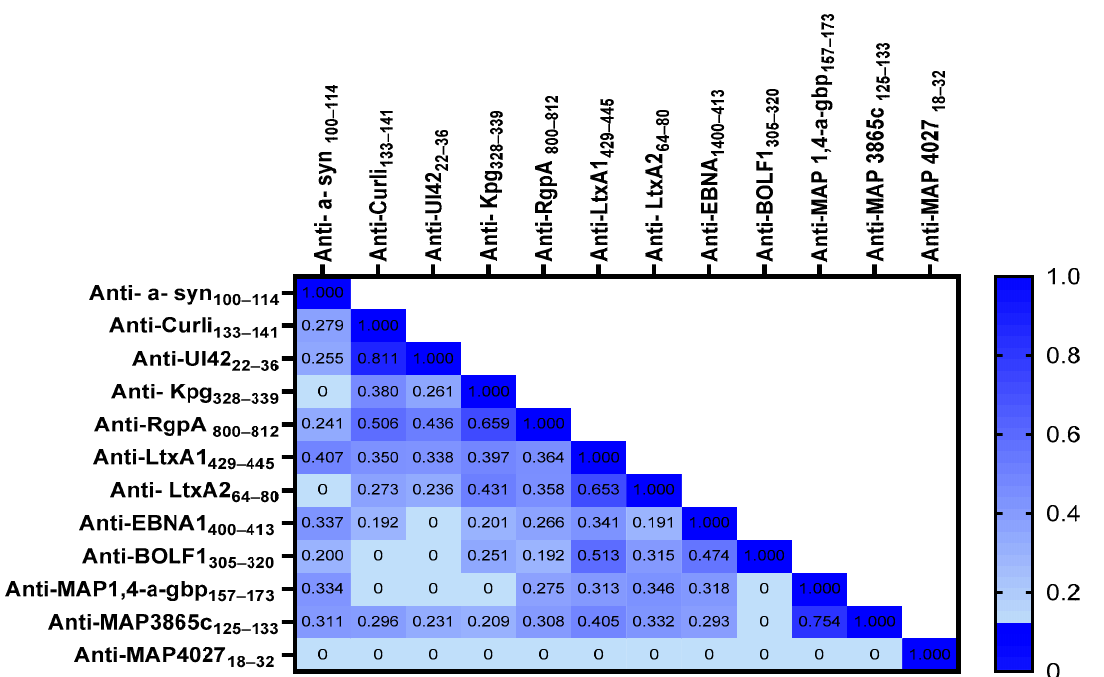
Figure 2. Heatmap shows the r values obtained from Spearman correlation analysis performed among derived peptides’